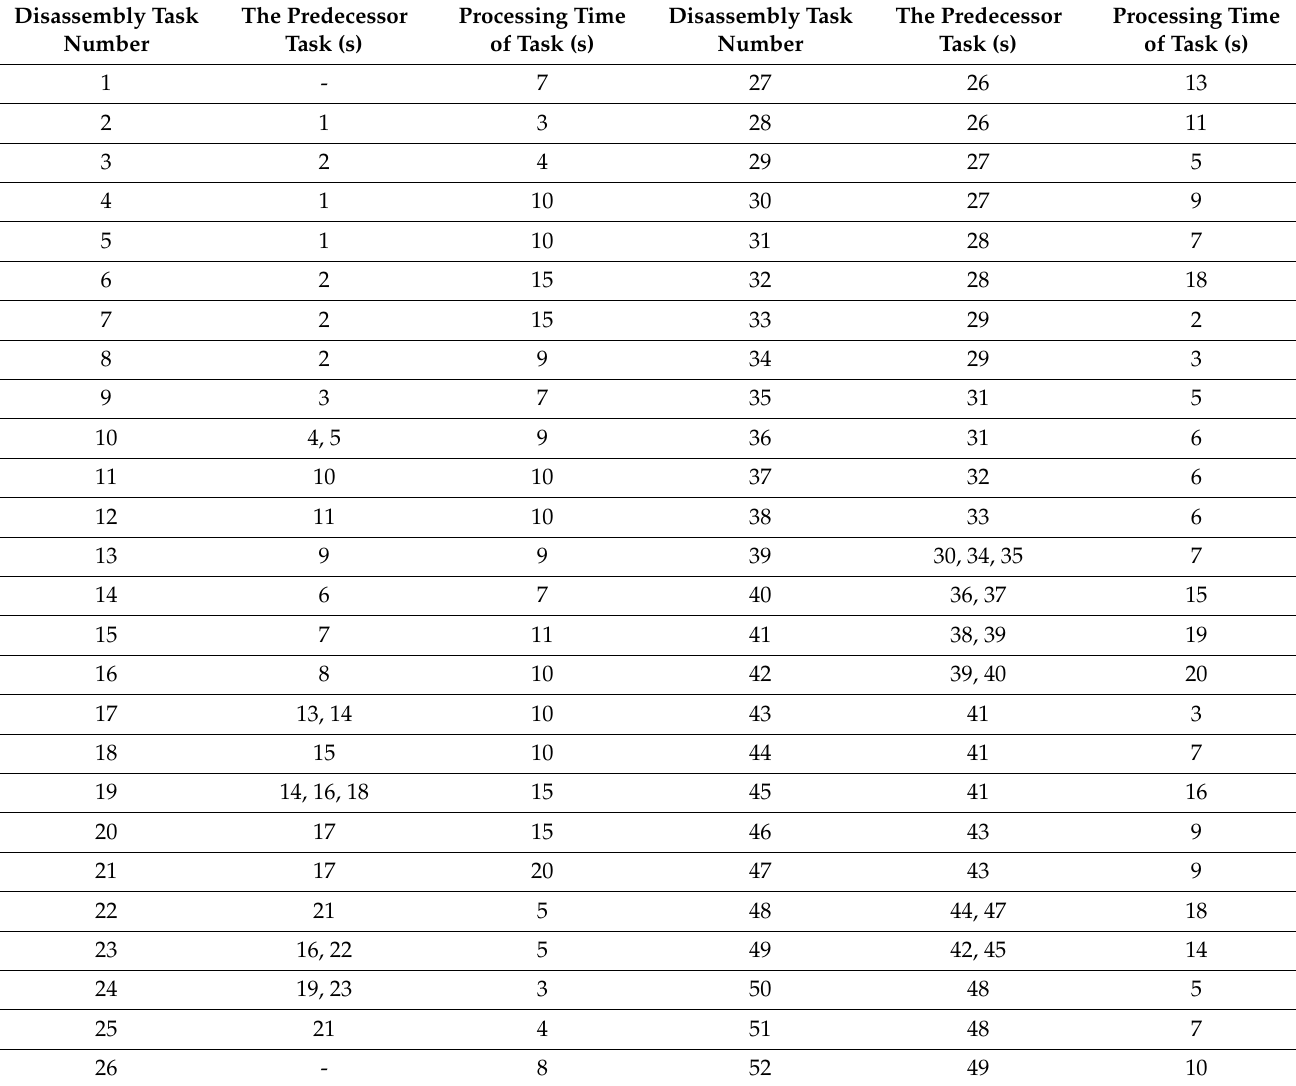
Table A1. Required tasks for the disassembly of the studied